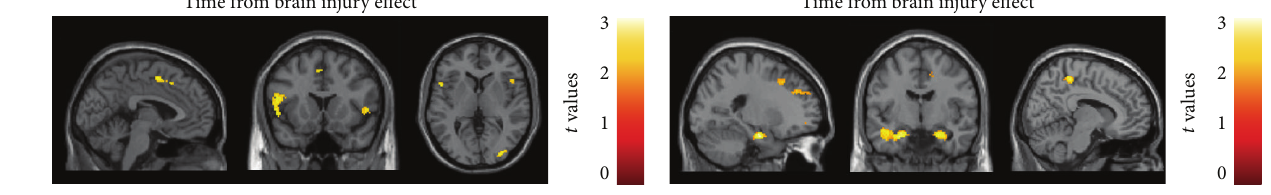
Figure 3: Brain regions showing significant group differences of fMRI activation during the modified Conners Continuous Performance Test (CCPT) (load effect) between acute/subacute and chronic patients with acquired brain injury (ABI) and healthy controls. (a) Significantly increased activation in chronic patients versus controls and acute/subacute patients; (b) significantly increased activation in acute/subacute patients versus controls and chronic patients. Results are shown at 𝑝 < 0.001 , uncorrected. Images are in neurological